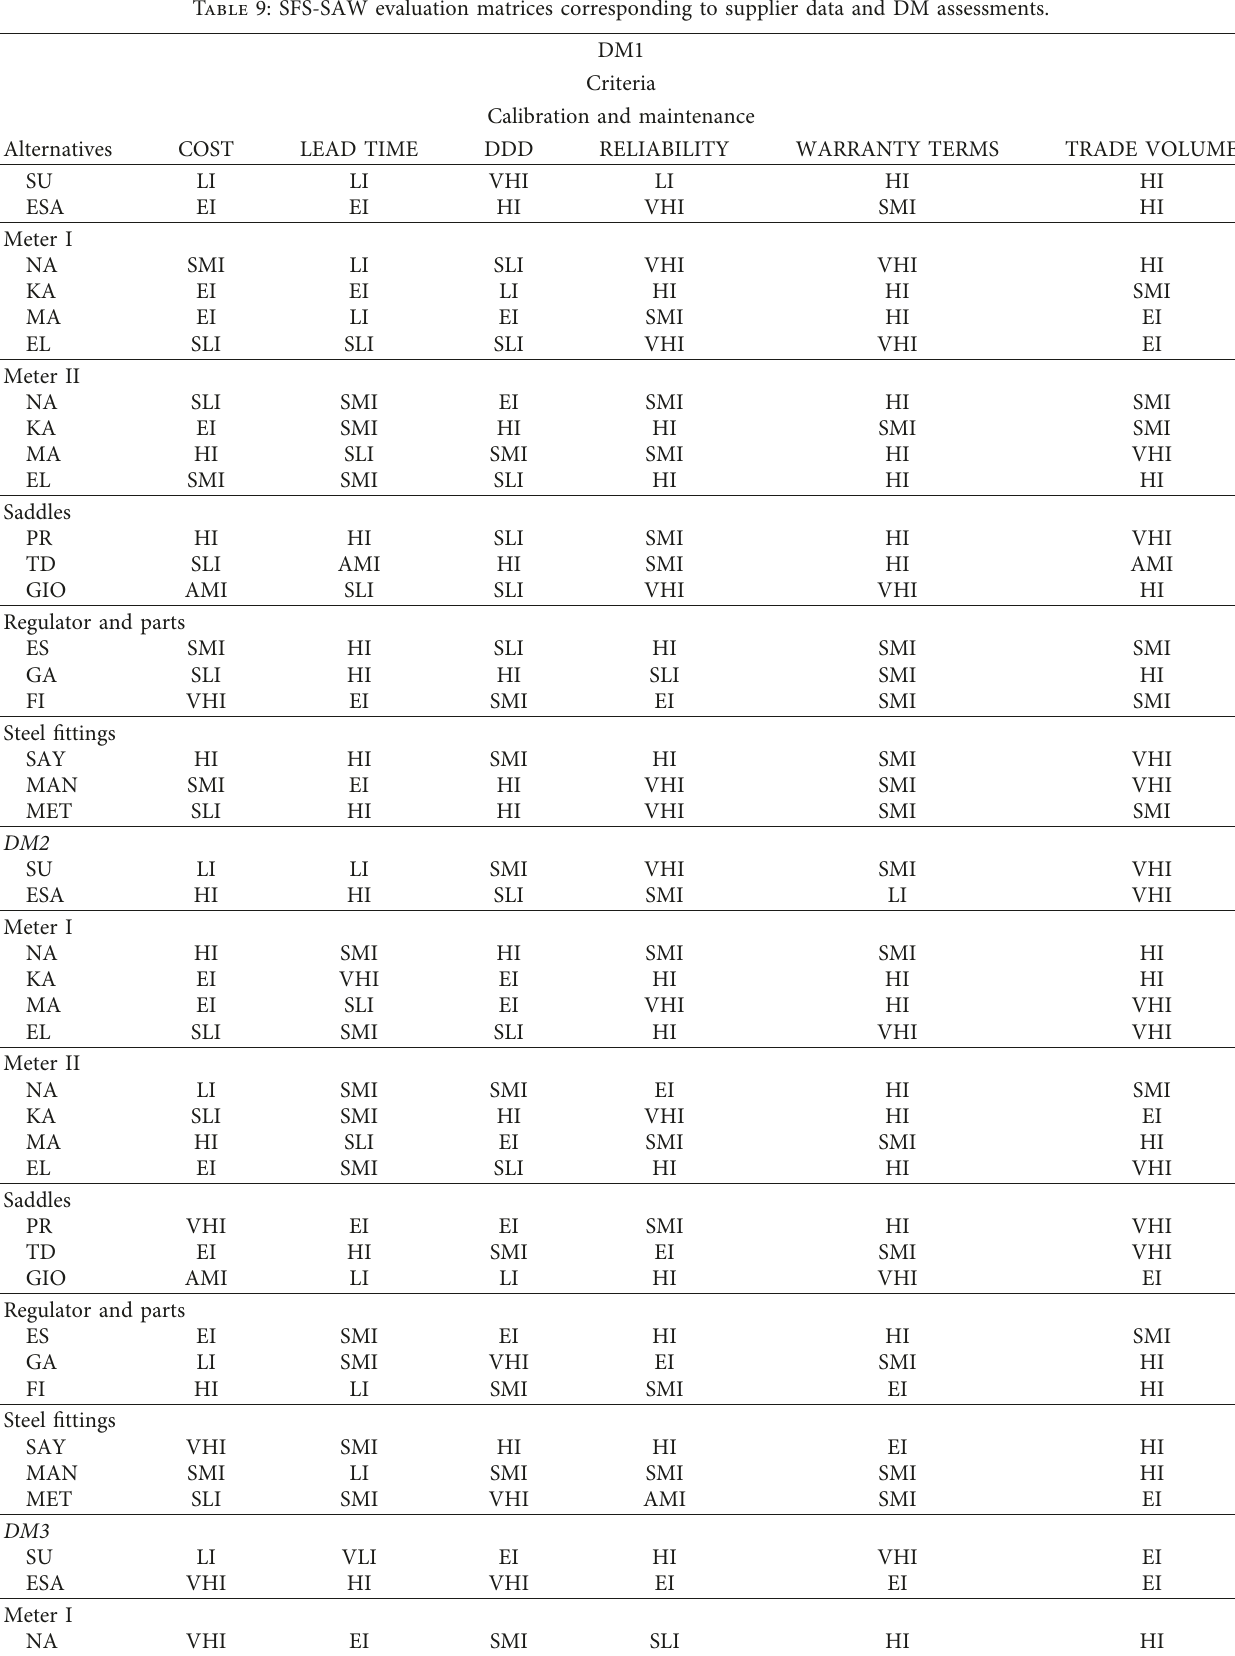
Table 9: SFS-SAW evaluation matrices corresponding to supplier data and DM